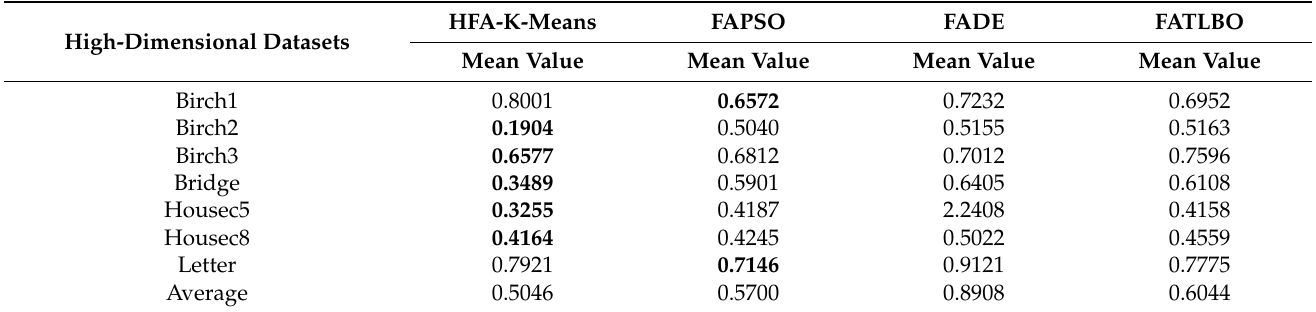
Table 9. Comparison of HFA-K-means with FA-based hybrid algorithms: FAPSO, FADE, and FATLBO on seven high-dimensional